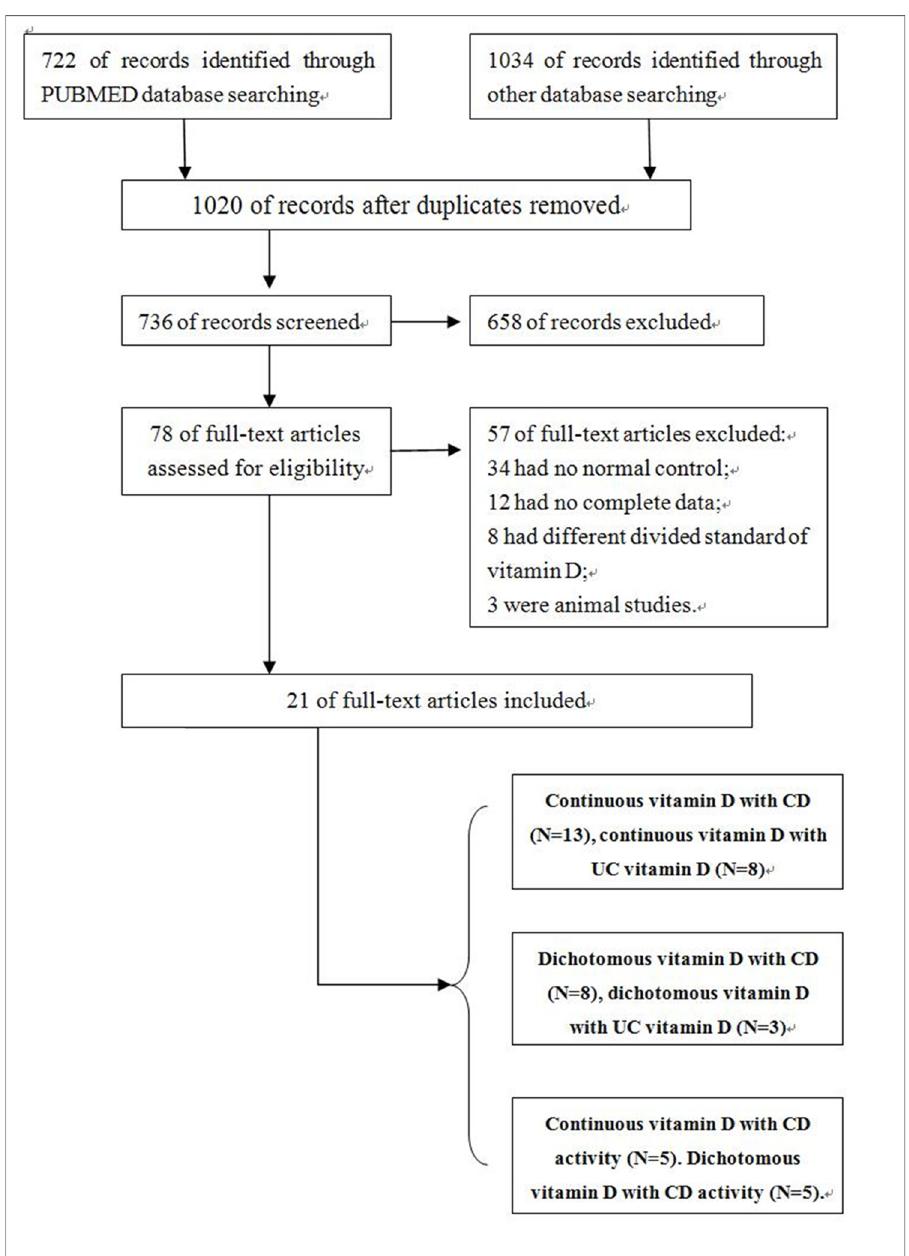
Fig 1. Flow diagram of